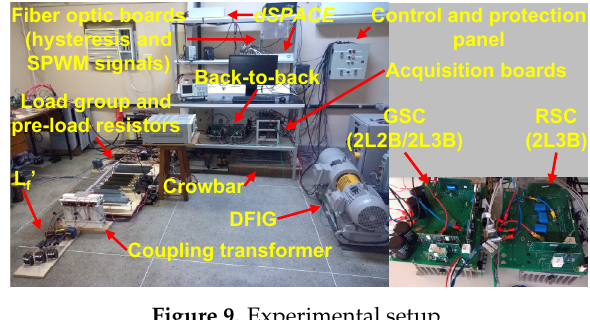
Figure 9. Experimental setup. Table 3. Experimental setup